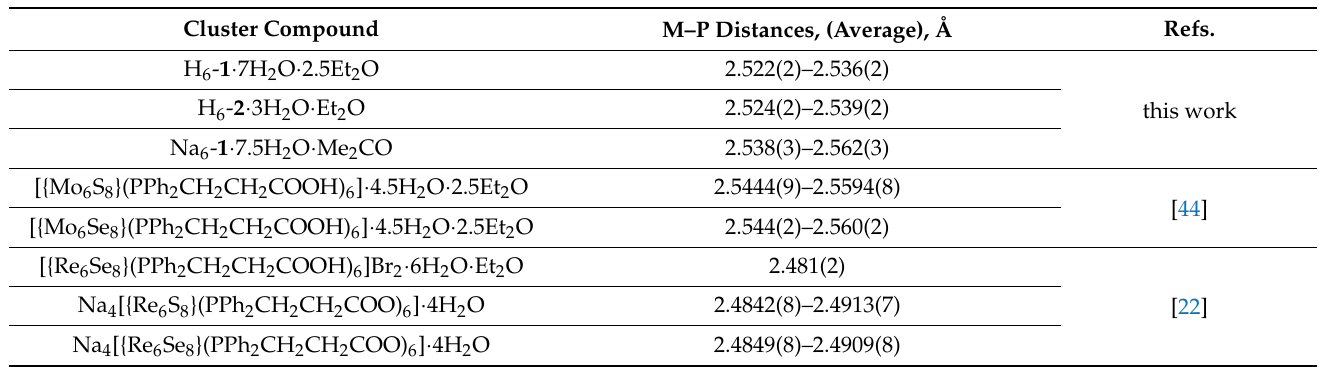
Table 1. M–P bond length analysis (M = Mo, W, and